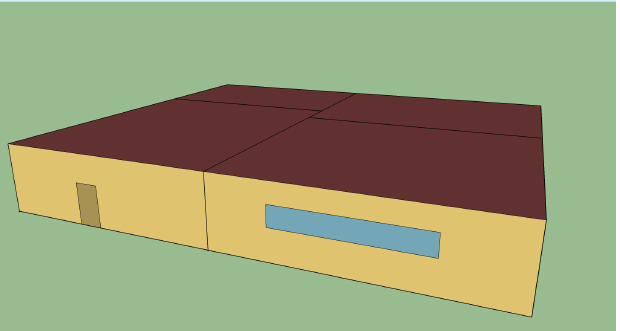
Figure 6. The multi-zone sketchup model construction used for